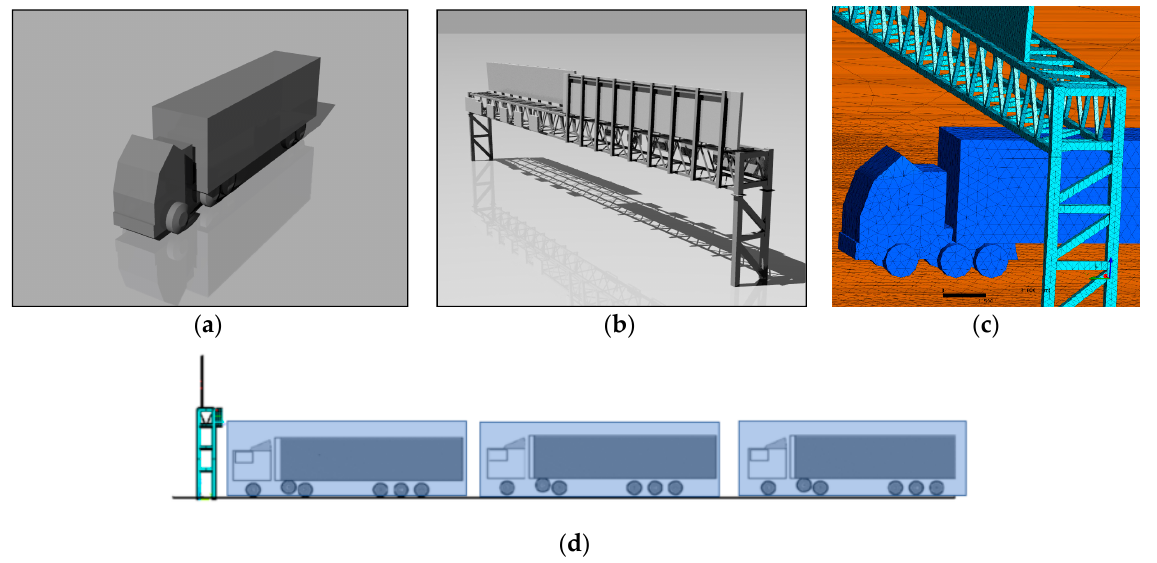
Figure 2. ( a ) CAD models for a typical high sided vehicle (HSV); ( b ) gantry structure (stationary zone); ( c ) overlapped discretized numerical domain; and ( d) HSVs’ arrangement for fatigue assessment scenarios with three moving zones.